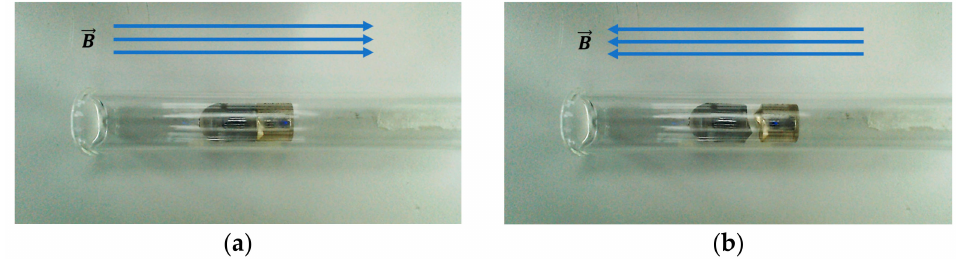
Figure 7. Experiment testing assembly by attractive force and separation by weak repulsive force. ( a ) Assembly by attractive force: the direction of the external magnetic field is the same as that of the permanent magnet. ( b ) Separation by weak repulsive force: the direction of the external magnetic field is opposite to that of the permanent